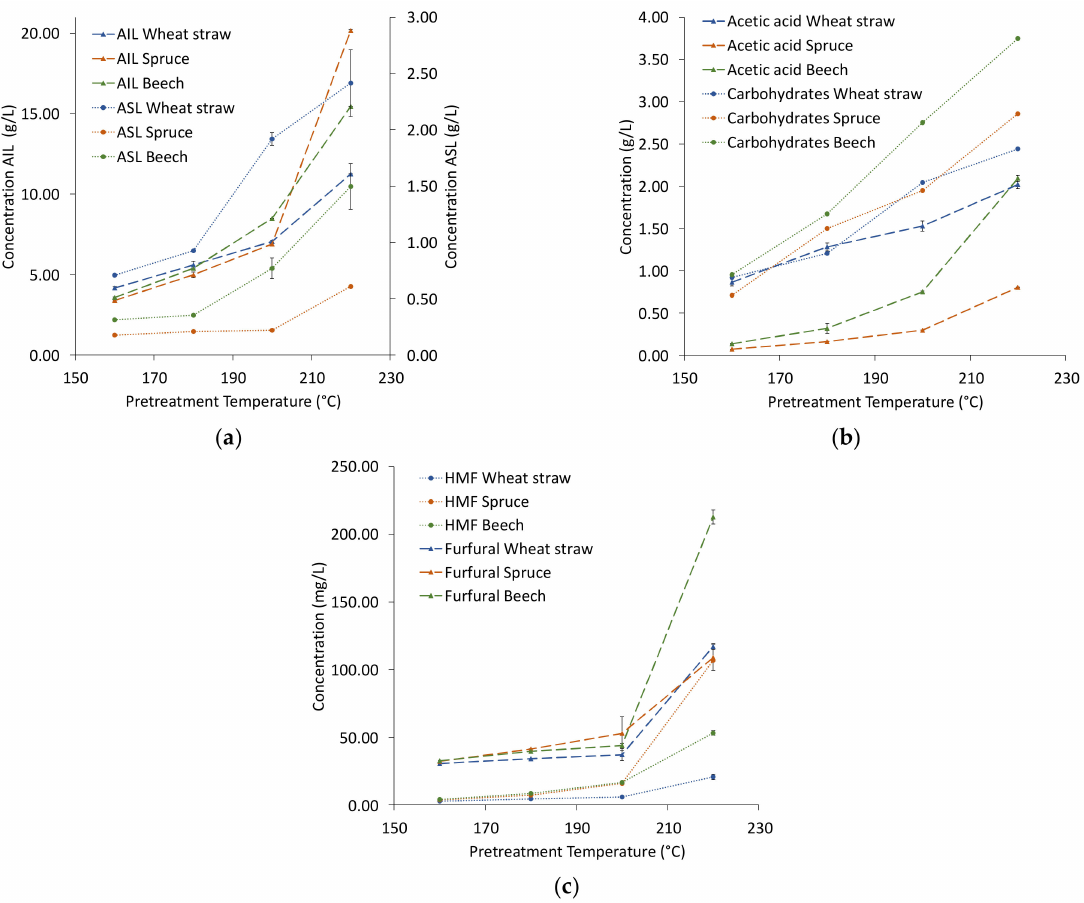
Figure 2. Concentration of lignin ( a ), acetic acid and carbohydrates ( b ), and degradation products ( c ) in organosolv extracts. Abbreviations: AIL—acid insoluble lignin, ASL—acid soluble lignin,